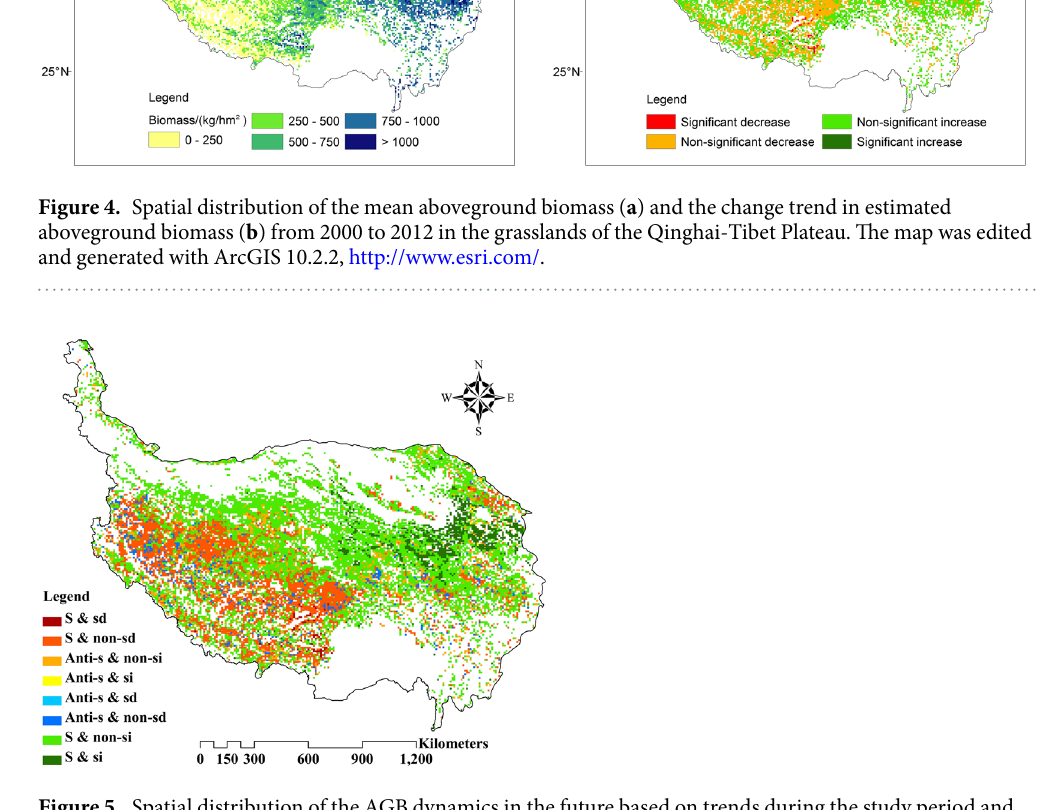
Figure 5. Spatial distribution of the AGB dynamics in the future based on trends during the study period and the Hurst exponent. S: sustainability; Anti-s: anti-sustainability; sd: significant decrease; non-sd: non-significant decrease; si: significant increase; non-si: non-significant increase. The map was edited and generated with ArcGIS 10.2.2,